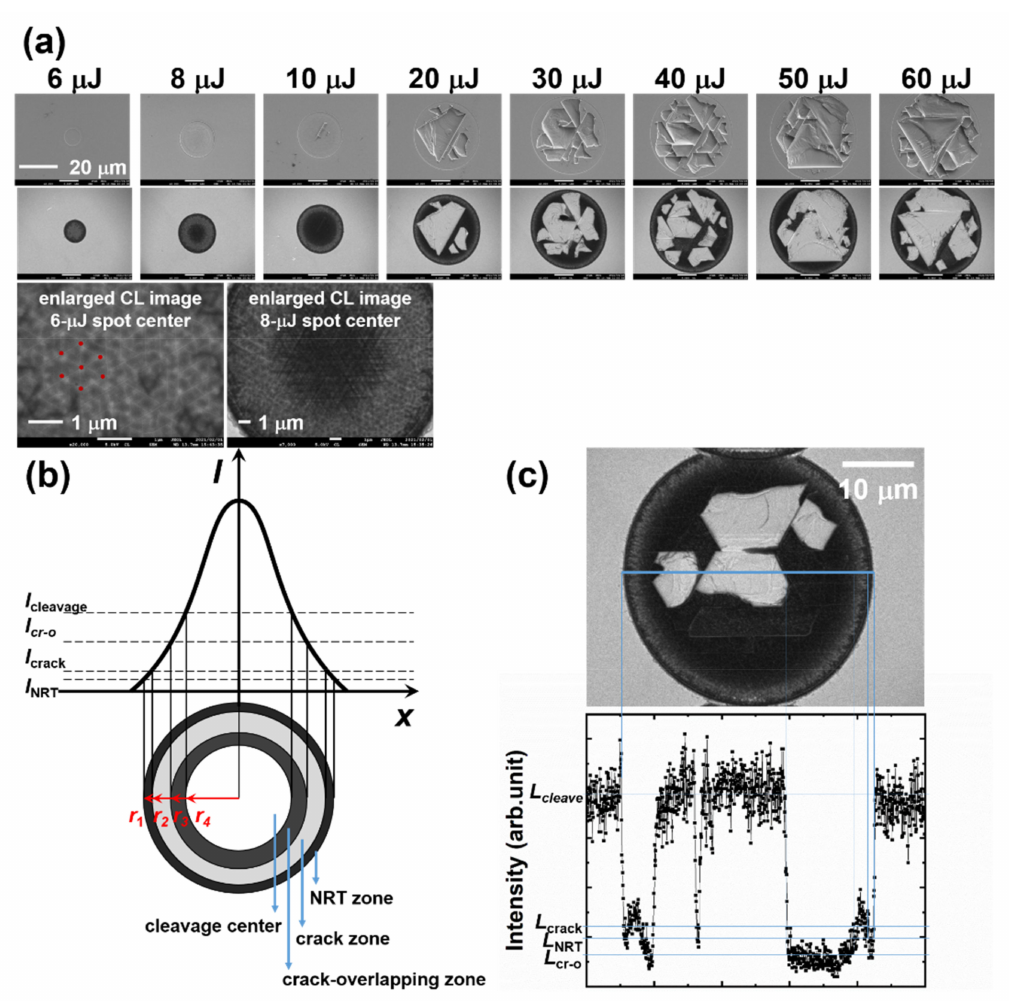
Figure 7. ( a ) SEM (top) and CL (bottom) images of the one-pulse irradiated spot. The red points in the enlarged CL image of the 6- µ J irradiated spot are the vertices of the triangles that combine to form the hexagon. The enlarged CL image of the 8- µ J irradiated spot shows a crack-overlapping center surrounded by the crack zone. ( b ) Image of the cleavage center, crack zone, crack-overlapping zone, and NRT zone of the laser-irradiated spot when the intensity is sufficiently high to induce surface cleavage. ( c ) The CL image and a line profile of luminescence intensity in a 20- µ J irradiated